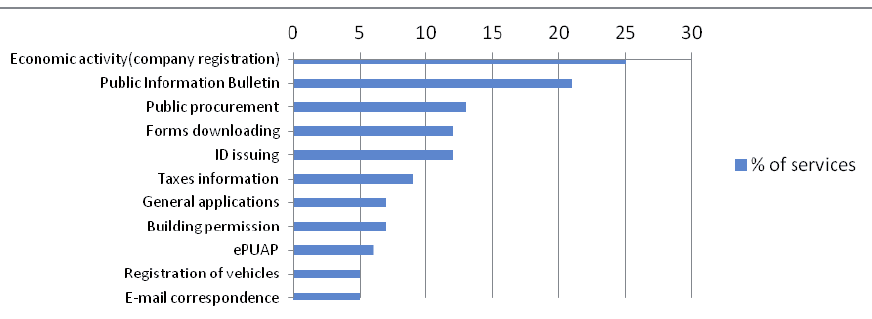
Figure 3. The most popular e-services in Poland in 2011 Source: